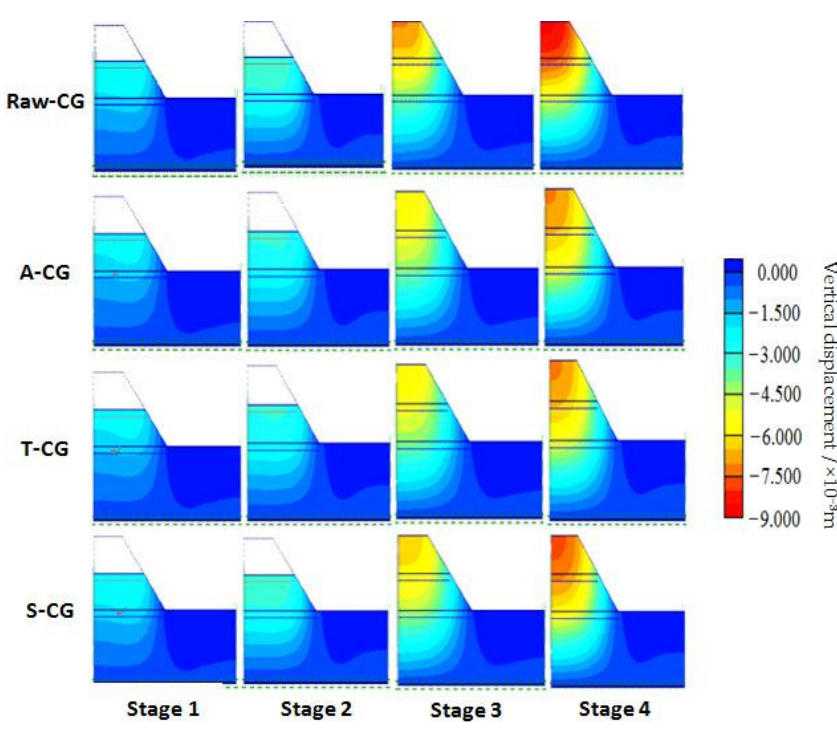
Figure 2. Displacement cloud model.